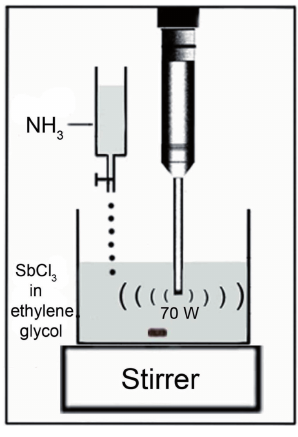
Figure 1. Schematice of the experimental setup used for the sonochemical reaction.